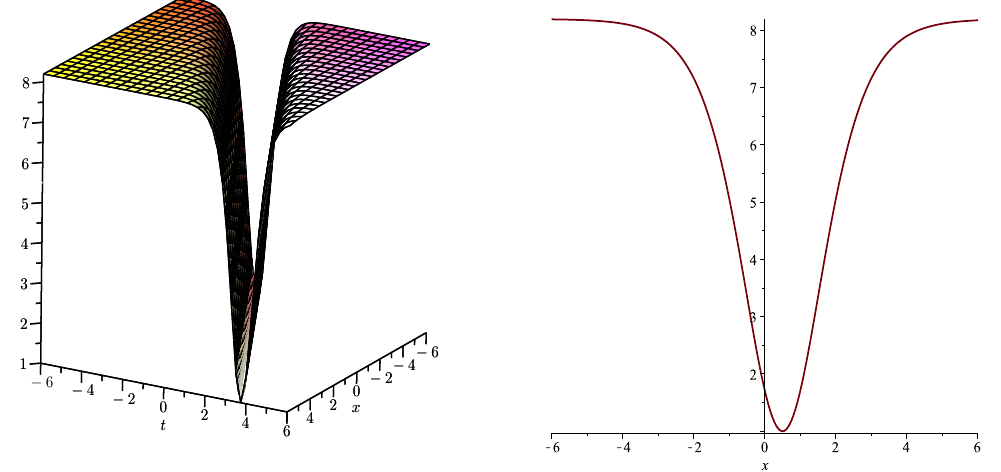
Figure 6. ( left ) 3D representation of solution (38) for ν = 1.5, κ = 0.5, ω = 0, ρ = 0, r = 1.2, p = 1, d = 1, ξ = 2, ξ 0 = 1.5 and